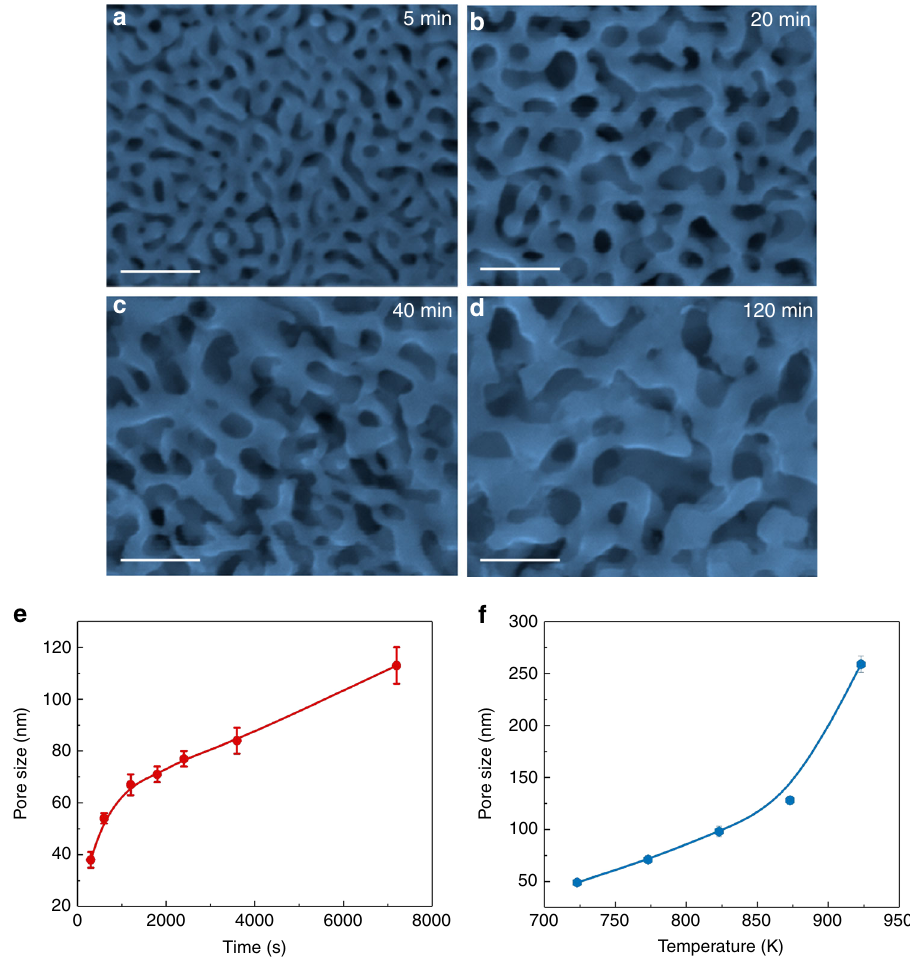
Fig. 2 Microstructure characterization of nanoporous cobalt under low-vacuum. a – d SEM images of nanoporous cobalt with various dealloying time from 5 to 120 min at 773 K and 100 Pa. a – d Scale bars, 200 nm. e The evolution of pore size with dealloying time. f The relation between pore size and dealloying temperature at a fi xed dealloying time of 30